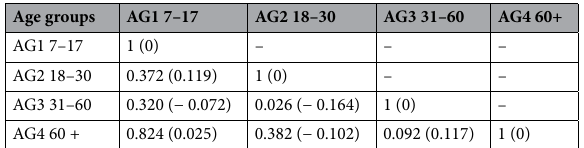
2 (in bracket) based on paired Wilcoxon tests for TLX scores in four age